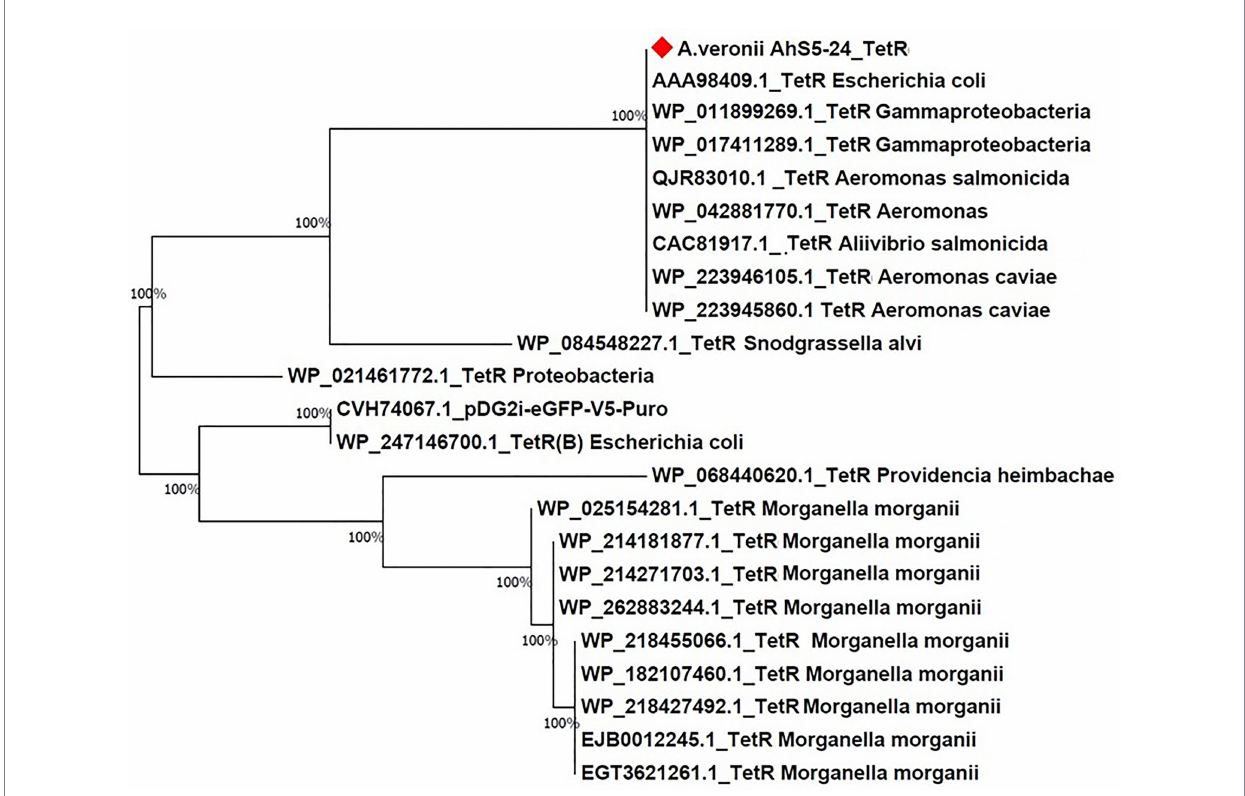
FIGURE 6 Phylogenetic tree comparing the tetR gene from different bacteria species. Note the high (100%) similarity between the tetR gene of Aeromonas veronii strain AhS5-24 with tetR genes of Escherichia coli (AAA98409.1), Gammaproteobacteria (WP_011899269.1 and WP_017411289), Aeromonas salmonicida (QJR83010.1), Aeromonas spp. (WP_04288770.1), and Aeromonas caviae (WP_223946105.1 and